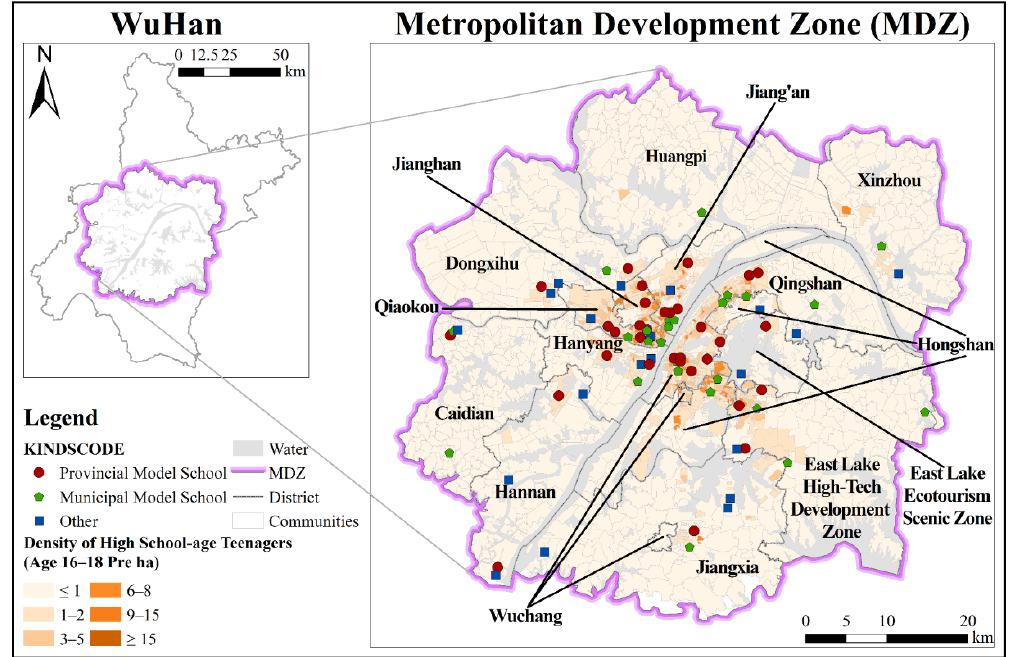
Figure 3. The Metropolitan Development Zone (MDZ) of Wuhan.